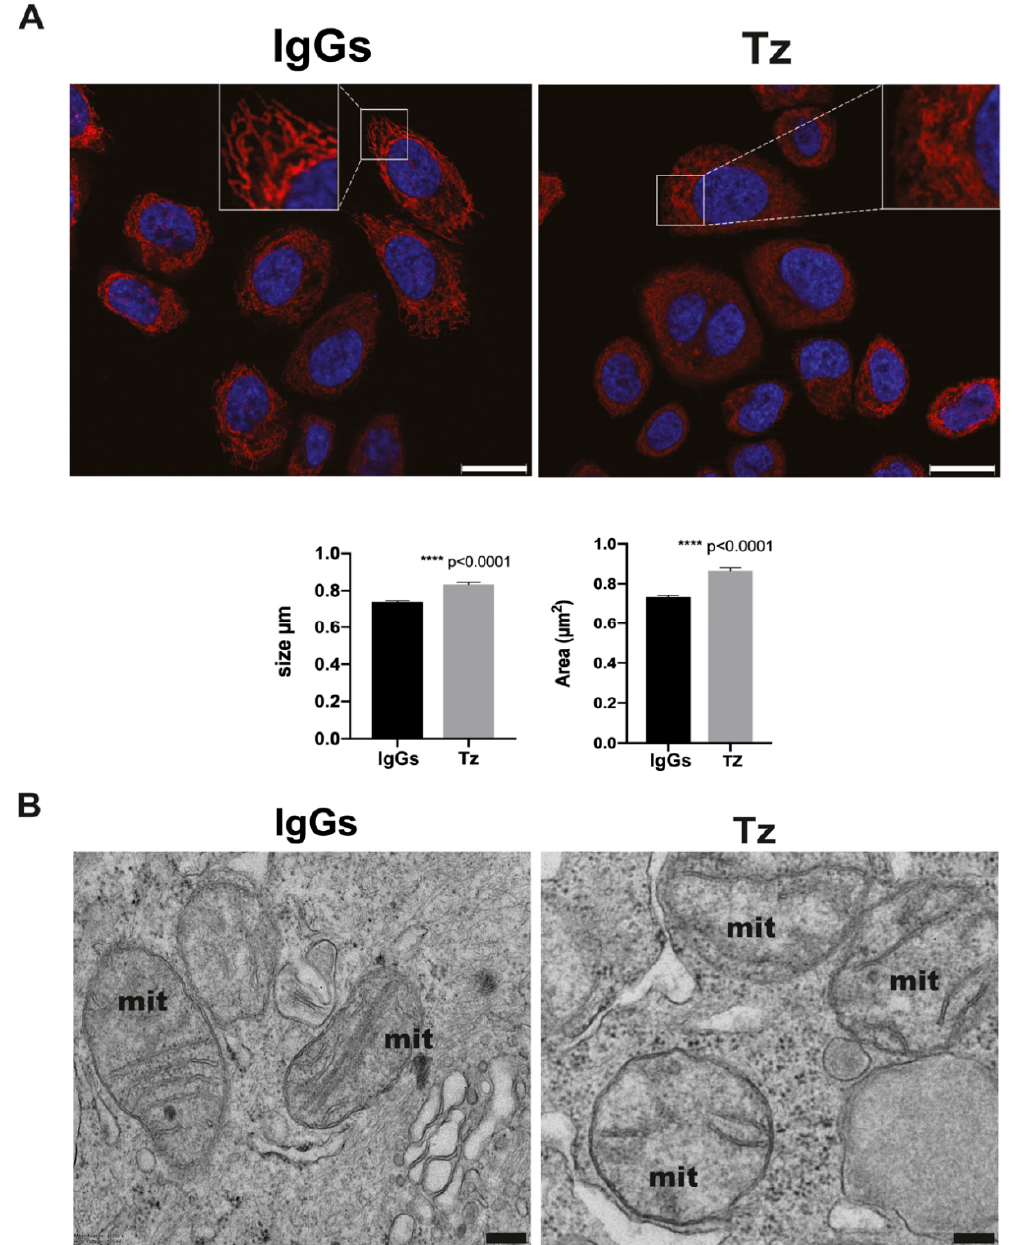
Figure 5. Fluorescence and TEM imaging of SKBR-3 cell mitochondria. ( A ) Mitochondria stained with MitoTracker Red display altered morphology (magnification insets) and increased size and area in cells treated with Tz compared to controls (IgGs). **** p < 0.0001. Size bar = 20 µ m. ( B ) TEM micrographs showing mitochondria in Tz-treated cells with abnormal architecture and reduced number of cristae compared to controls (IgGs). Size bars: 200